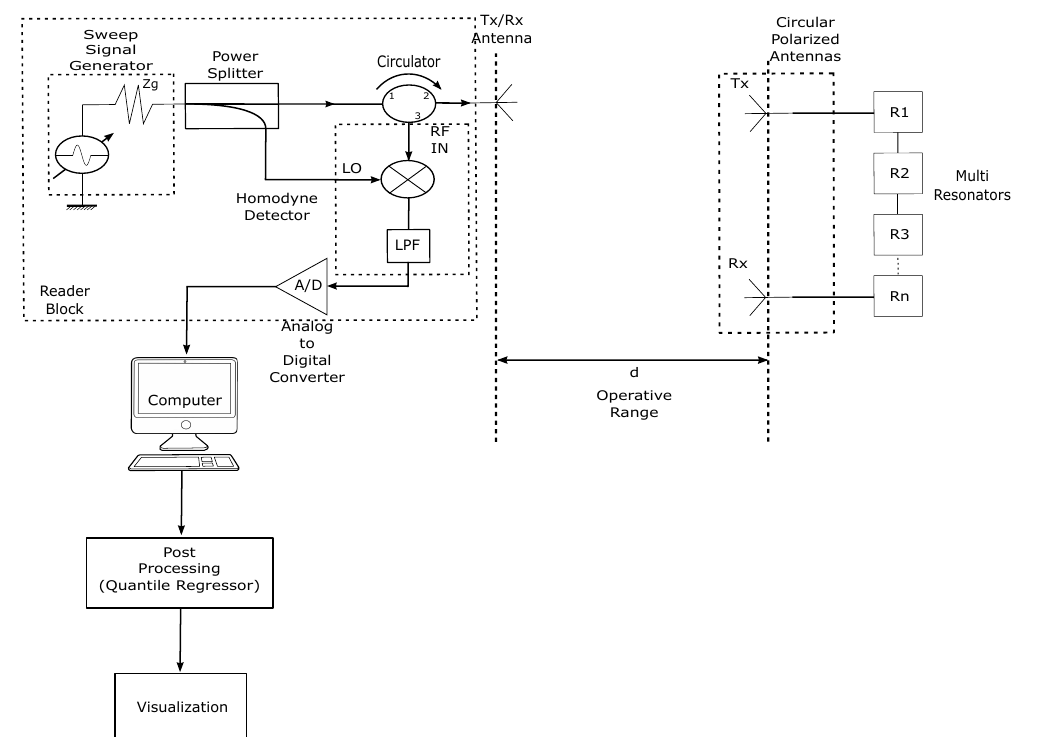
Figure 1. Chipless Radio Frequency Identification (RFID) system schematic.